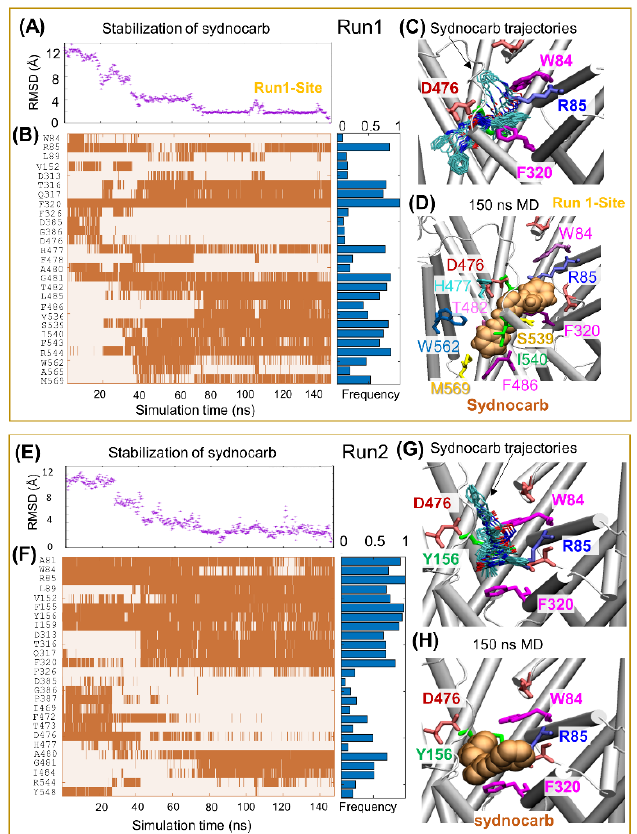
Figure 3. MD simulations reveal multiple binding poses of sydnocarb in hDAT. Left and right boxes display results from two independent runs: Run1 and Run2. ( A , E ) Sydnocarb diffusion as a function time estimated by the RMSD of sydnocarb atoms with respect to the final pose at 150 ns. ( B , F ) Time evolution of contacts (<4.0Å closest atom–atom distance) between DAT and sydnocarb (indicated by orange-shaded areas) with the binding frequency summarized by the horizontal blue bars on the right panel. ( C , G ) Sydnocarb-binding poses captured in simulations with a snapshot taken every 4 ns. The ligand conformations are shown in cyan sticks. ( D , H ) MD-resolved final poses of sydnocarb (light orange vDW) observed at the end of MD Run1 and Run2. Results for MD simulation Run3 and Run4 can be found in Supplementary Information Figure S3.